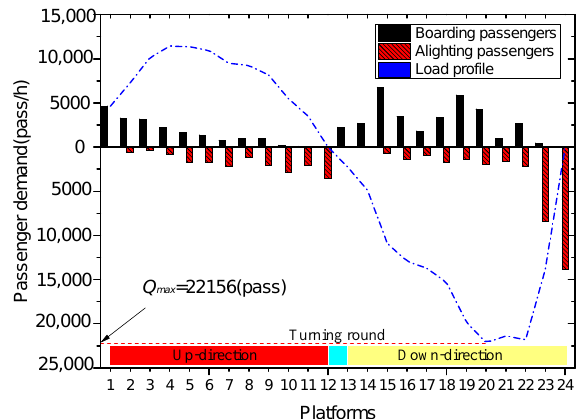
Figure 7. Changping Line of the Beijing urban rail transit network.